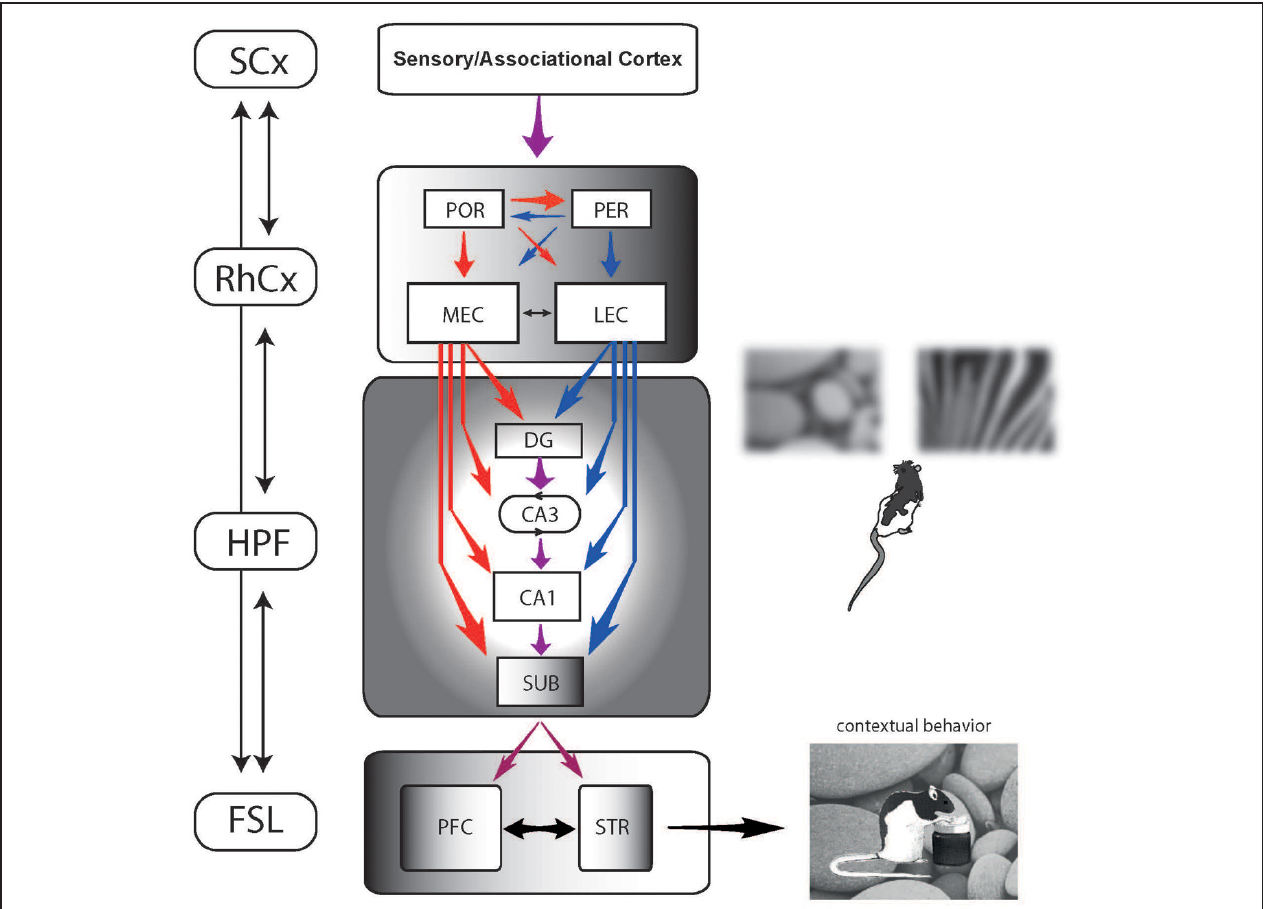
FIGURE 9 | A schematic illustration of the information flow and interactions among the brain regions (selectively chosen) involved in contextual behavior (connections are simplified for illustrative purposes). Via primary and higher-order sensory cortices (SCx), multimodal perceptual information from the environment enters the rhinal cortical regions (RhCx) that include the post-rhinal cortex (POR), perirhinal cortex (PER), medial entorhinal cortex (MEC), and lateral entorhinal cortex (LEC). The areas in the RhCx may interact with each other to varying degrees as indicated by arrows. It is hypothesized that qualitatively different information-processing streams exist in the RhCx, denoted by red arrows (contextual information) and blue arrows (item information) here. The qualitatively different information streams continue as the information enters the hippocampal formation (HPF) in which associative processes occur between these two streams (presumably in order to form an event representation). The